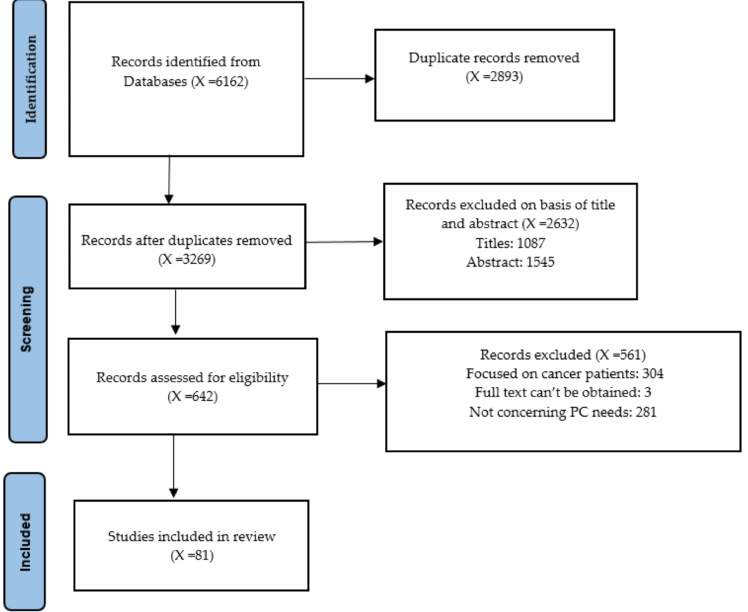
Figure 1. Study selection Prisma Flow